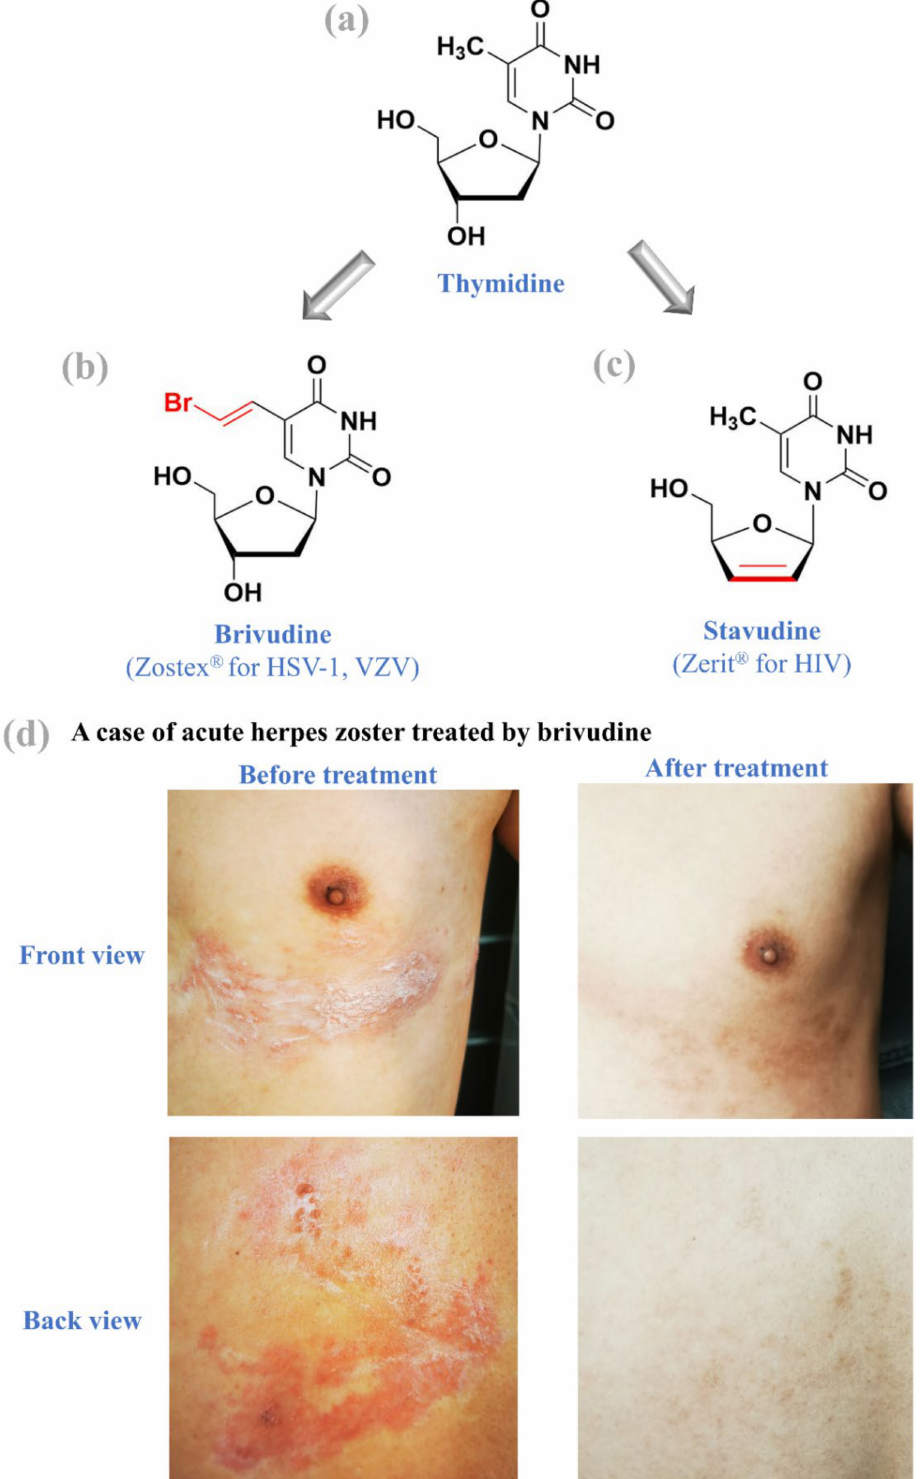
Figure 3. Thymidine and thymidine nucleoside analogues. Development from thymidine ( a ) to brivudine ( b ) and stavudine ( c ). A case of acute herpes zoster was treated by brivudine ( d ). In the first 3 days after symptom onset, a corticosteroid topical cream (mometasone furoate) offered no improvement. Based on the advice of our beloved professor Erik De Clercq, three once-daily tablets of brivudine (Zostex ® ) were subsequently used to cure the herpes zoster, and all crusts fell off 3 weeks later. Front and back views were taken before the brivudine treatment and 2 months after the